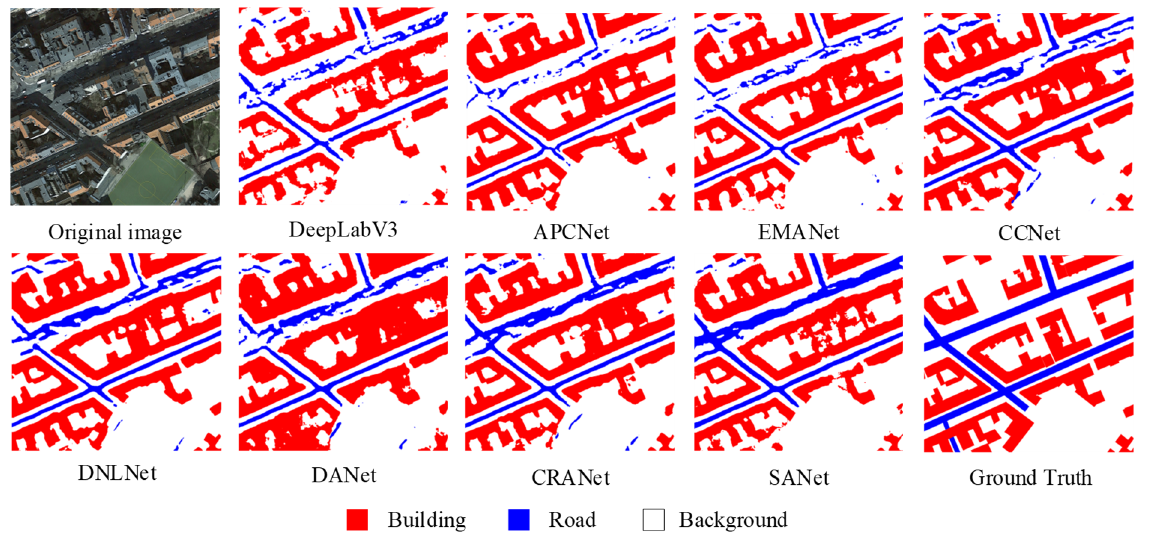
Figure 15. Comparison of visual results of each method based on CITY-OSM dataset. Table 8. Comparison with other methods based on the DeepGlobe dataset. Data in bold are the best results.